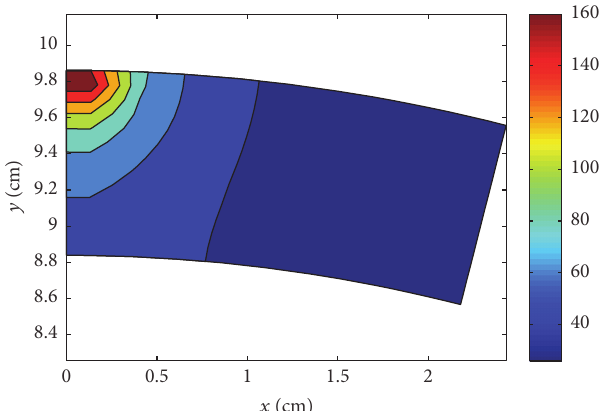
Figure 3: The longitudinal map of the LED heat sink considered in this paper.